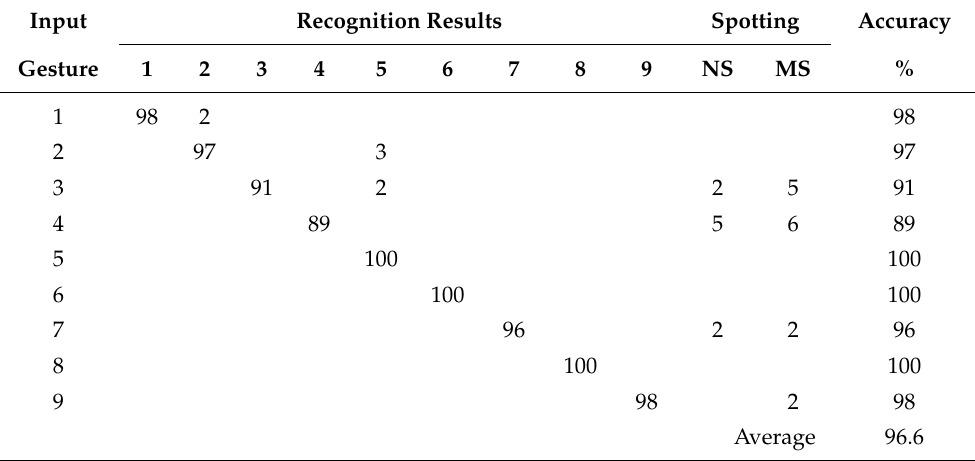
Table 2. Confusion table (5 fps).